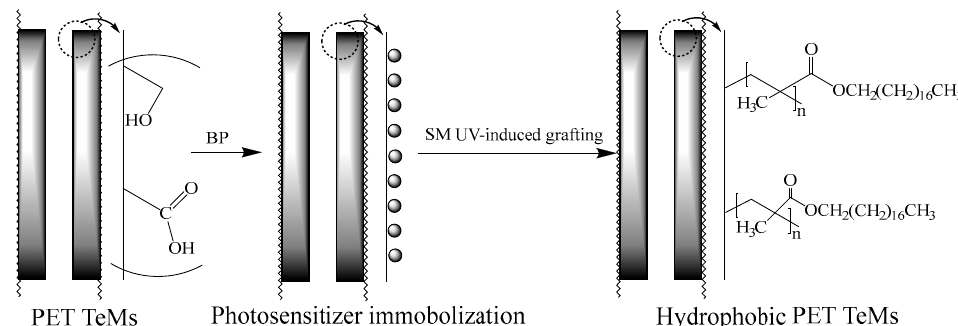
Figure 1. Scheme of PET TeMs hydrophobization.